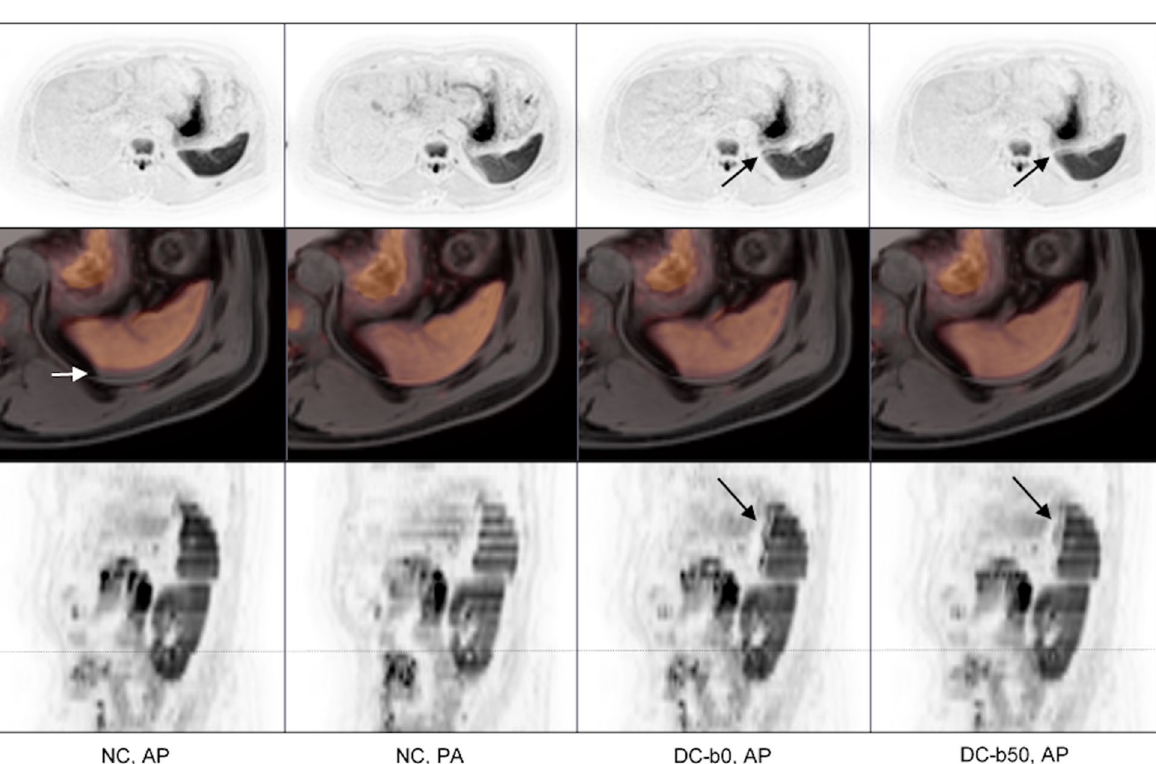
Figure 6. Typical registration artefacts caused by the RPG method as observed at 1.5T. Axial b50 images ( a ) axial b50 images overlaid on corresponding structural images ( b ) and sagittal b50 images ( c ) are shown. In each column (left to right) the non-corrected (NC) anterior–posterior (AP), NC posterior-anterior (PA), b0-based distortion corrected (DC-b0) AP and b50-based distortion corrected (DC-b50) AP images are displayed. Axial and sagittal b50 images in inverted grey scale show spleen registration artefacts as marked by arrows ( a , c ). Although artefacts are introduced, there is an improvement in the geometrical alignment. This is exemplified by zoomed axial b50 images in yellow color scale overlaid on corresponding structural images ( b ), with misalignment in the NC AP image indicated with an arrow. For the sagittal images the station border is marked with a dashed line. The radiologists’ assessments of overall image quality gave a mean score of 1.7 and 1.0 for the DC-b0 and DC-b50 images,